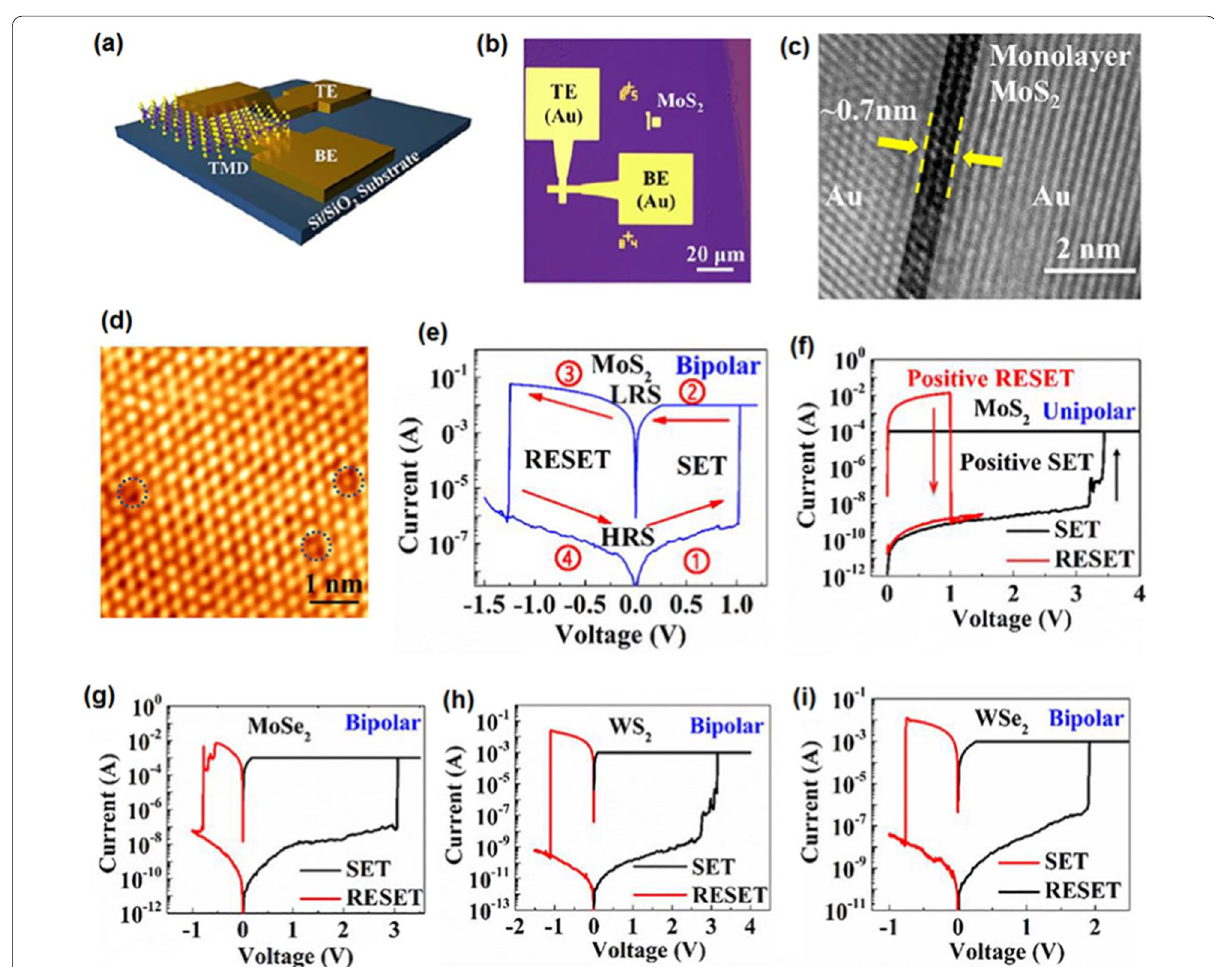
Fig. 14 a Schematic interpretation of metal/insulator/metal atomristor device based on TMDCs monolayers, b the corresponding optical image of device and the c cross-sectional TEM image of Au-Monolayer MoS 2 -Au device. d The atomically resolved STM image of monolayer MoS 2 film deposited on Au electrode. The sulfur vacancies indicated by dashed lines. e The typical I-V curve of atomristor device based on monolayer MoS 2 monolayer device. The typical bipolar RS behavior is observed. f The occasional unipolar RE behavior of device in monolayer MoS 2 device. g , h and i graphs respectively demonstrate the typical bipolar RS behavior of atomristor devices based on monolayer MoSe 2 , WS 2 and WSe 2 films. Reprinted with permission from